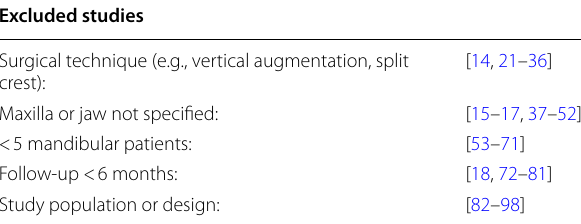
Table 1 Specification of excluded studies after full‑text